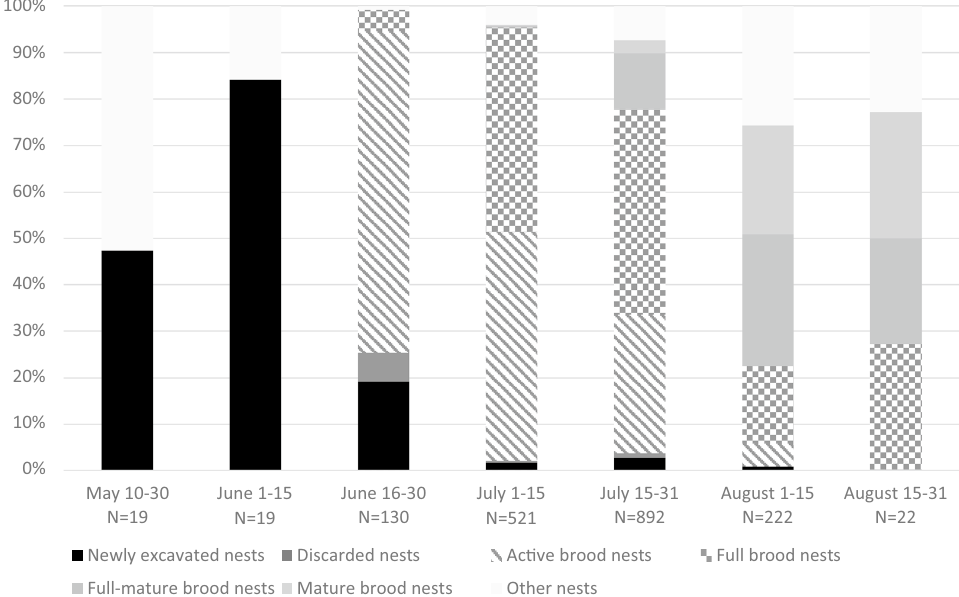
Figure 2. Phenology of C. nigrolabiata through nesting season.